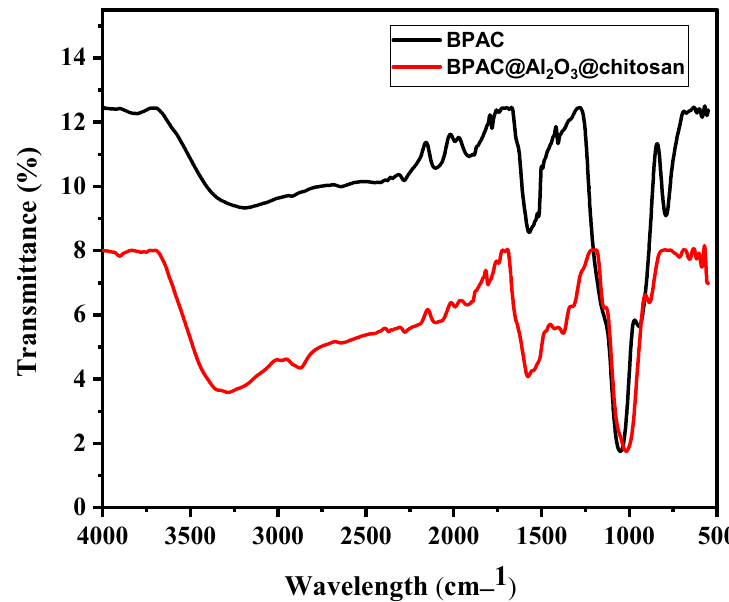
Figure 4. FTIR spectra of BPAC and BPAC@Al 2 O 3 @chitosan.